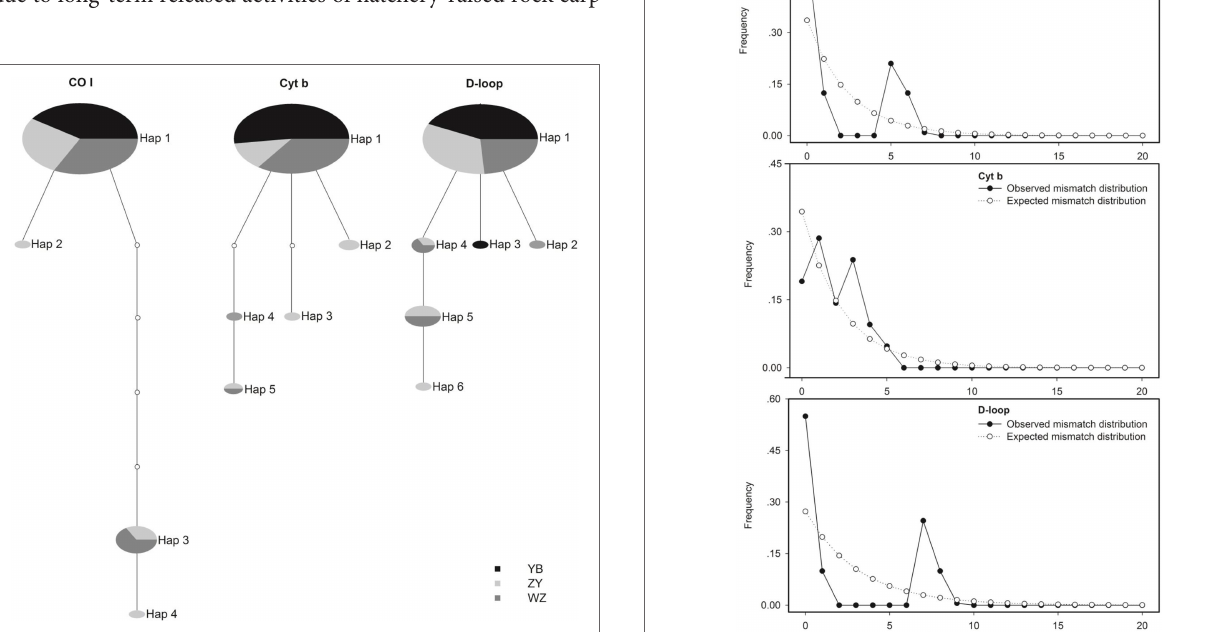
FIGURE 2 | Statistical parsimony network based on haplotype frequencies of the mtDNA CO I, Cyt b, and D-loop markers among the wild population (ZY), Yibin hatchery (YB), and Wanzhou hatchery (WZ) of Procypris rabaudi .